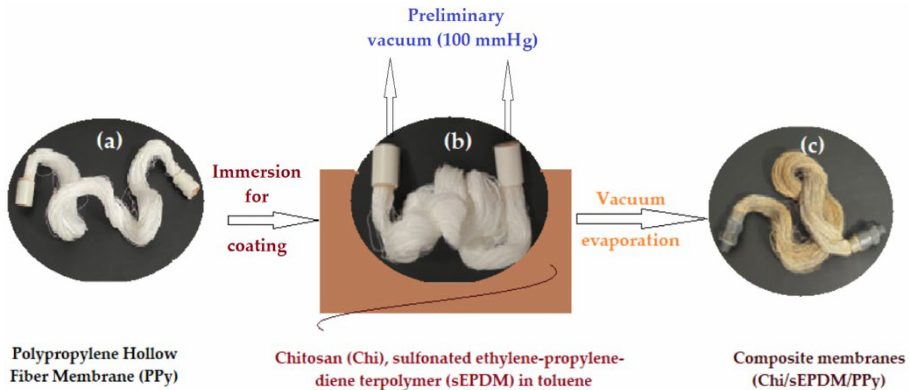
Figure 2. Schematic presentation of the Chi/sEPDM/PPy composite membrane production process: ( a ) virgin polypropylene hollow fiber membranes; ( b ) membranes immersed in the chitosan–sEPDM toluene dispersion bath; ( c ) composite membranes (Chi/sEPDM/PPy).